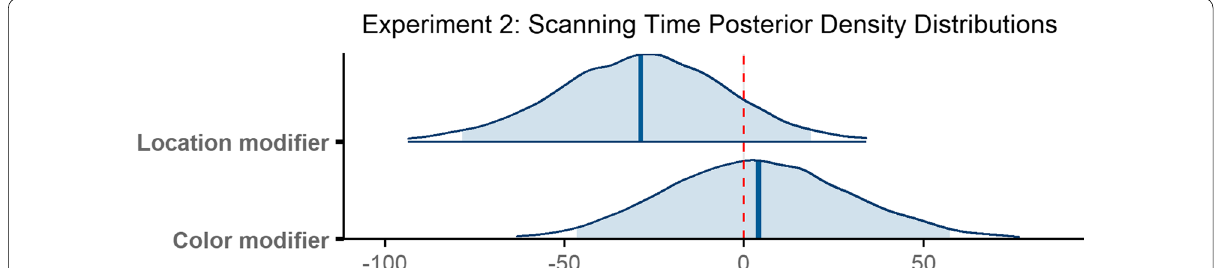
Fig. 10 Posterior density distributions for scanning time β parameter estimates for each level of the fixed effect relative to the reference level. Light blue shaded regions indicate the 95% credible interval and blue vertical lines indicate the mean of the distribution. The red vertical dashed line highlights 0 on the x axis. If the red line falls within the light blue shaded region, the estimate is not reliably different from zero and interpreted as a